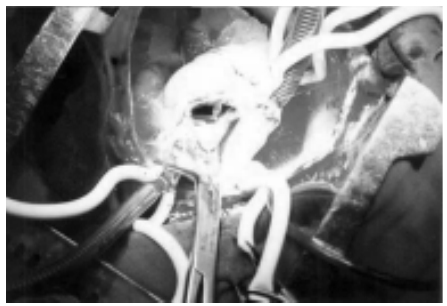
Fig. 5 – Surgical aspect of the non-coronary cuspid